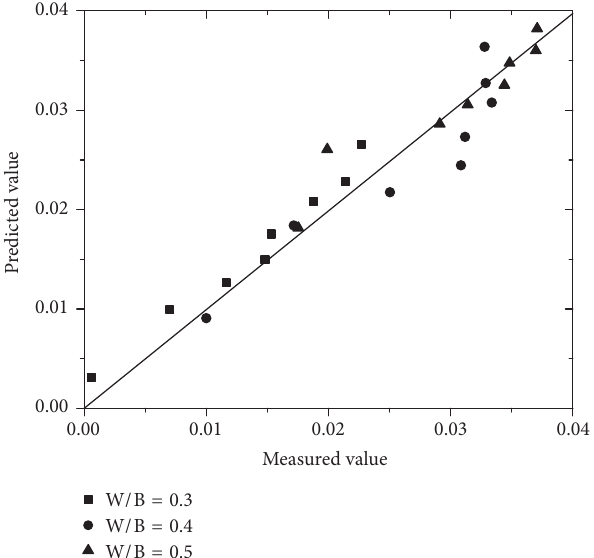
Figure 10: The predicted and measured values of the degree of cement hydration of enhanced cement-fly ash pastes.